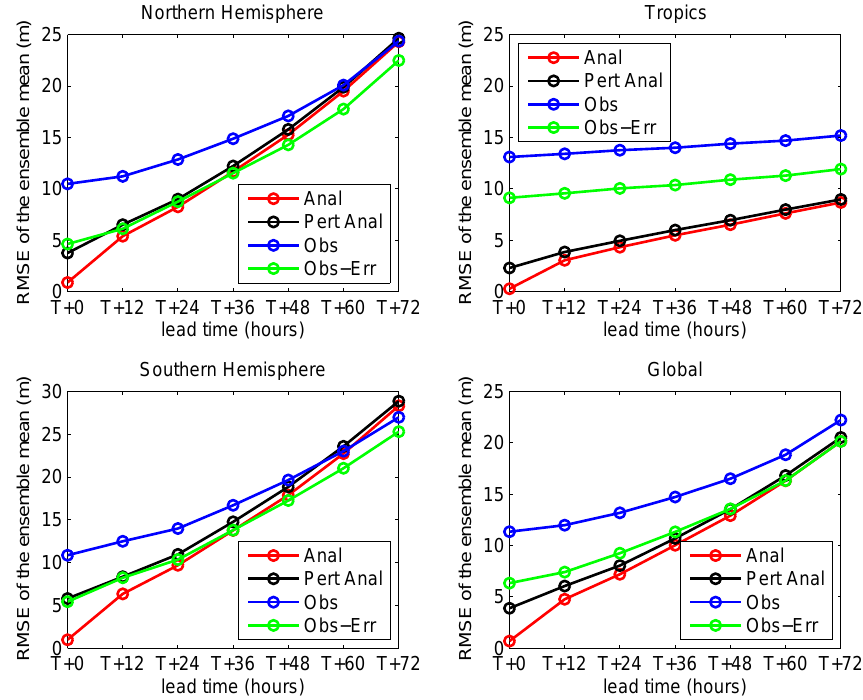
Figure 6. RMS errors of MOGREPS ensemble mean as a function of forecast lead time for forecasts of 500hPa geopotential height. The forecast errors are reported for verification against observations and perturbed and unperturbed analyses.